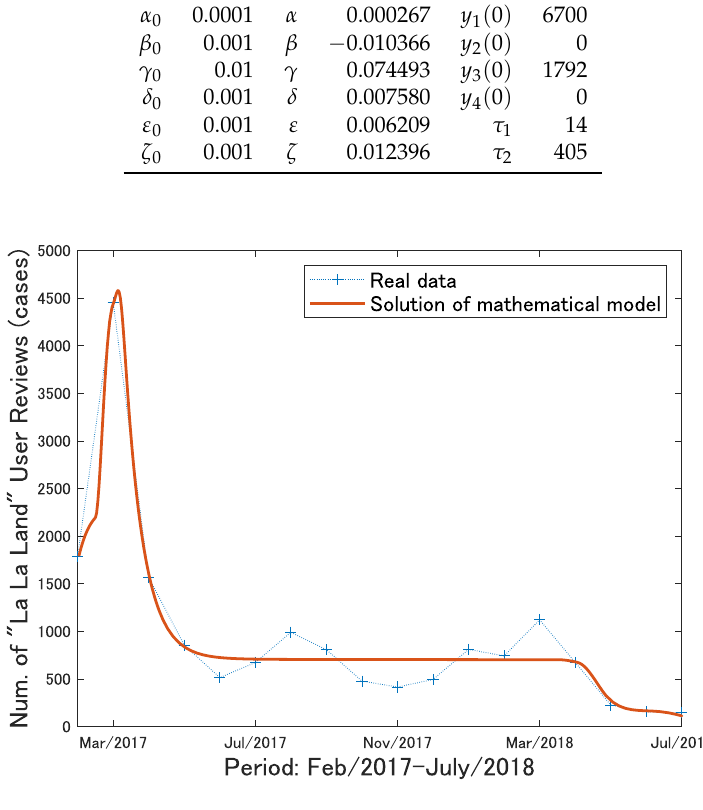
Figure 1. Fitting to La La Land